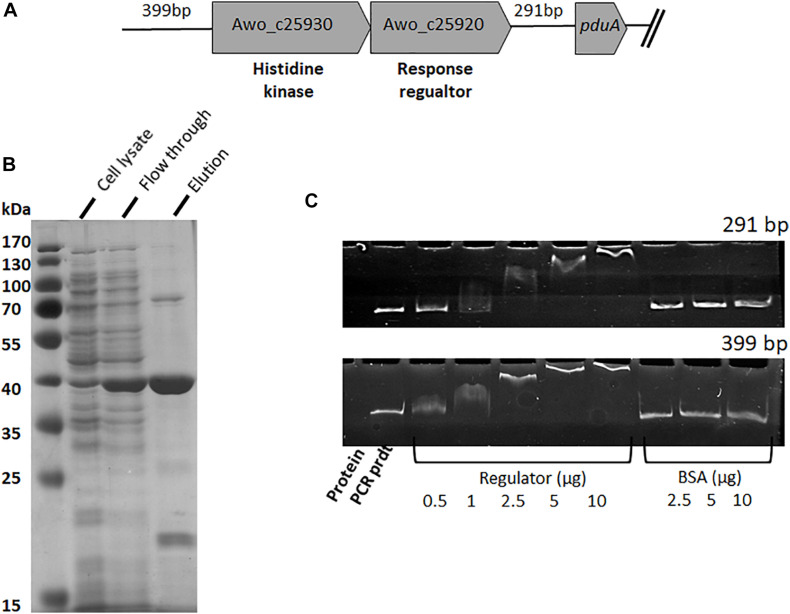
Binding of response regulator (Awo_c25920) to intergenic DNA of the pdu cluster. (A) Genetic organization of the histidine kinase and response regulator genes present upstream of the pdu gene cluster. Intergenic region upstream of his-kinase is 399 bp whereas downstream to the response regulator is 291 bp. (B) SDS-PAGE of purification steps of His 6-tagged response regulator, Awo_c25920, overproduced in E. coli. (C) EMSA performed with response regulator bound to two different intergenic regions. Shift assays contained 50 ng DNA template and increasing amount of regulator (0–10 μg protein), control assays received only DNA template and bovine serum albumin (2.5–10 μg protein). Samples were separated on a 6% native polyacrylamide gel, and the DNA was visualized with ethidium bromide.